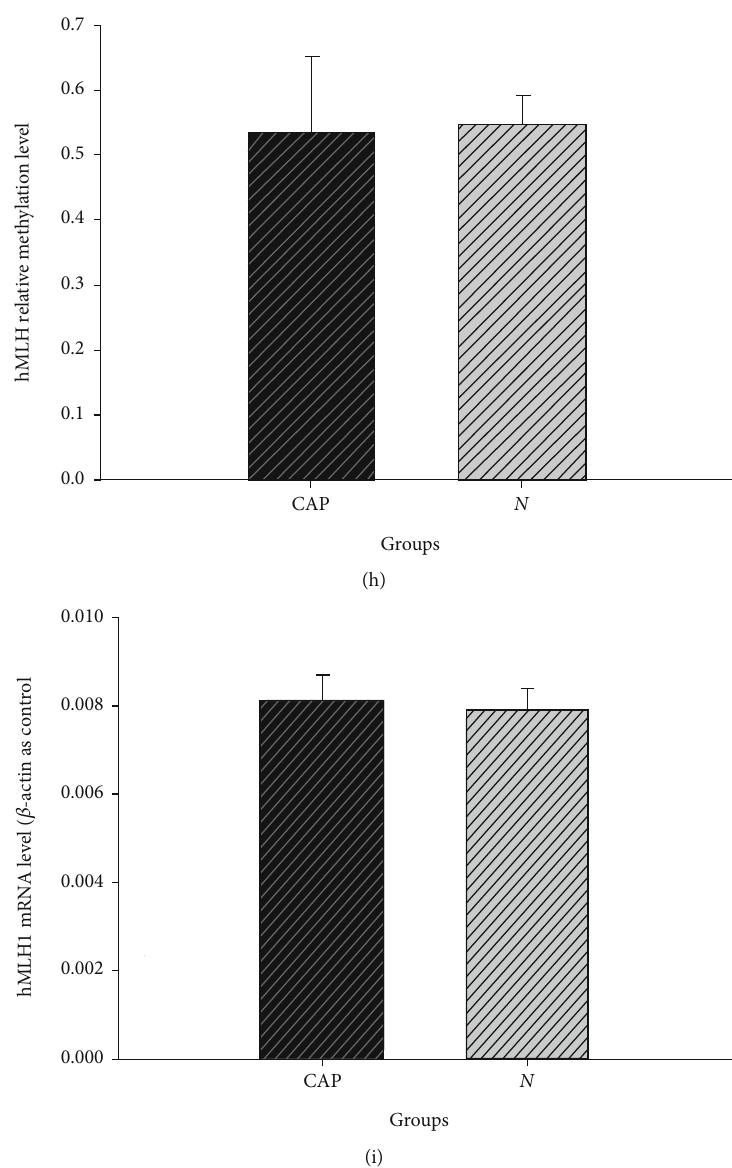
Figure 4: The methylation and expression of RASSF1A , p16 , and hMLH1 in CAP and NCM tissues. (a) MS-PCR analysis of methylation of RASSF1A . (b) Rate of DNA methylation in RASSF1A ( ∗ P < 0 : 05 ). (c) Real-time PCR analysis of the ration of RASSF1A mRNA to β -actin mRNA ( ∗ P < 0 : 05 ). (d) MS-PCR analysis of methylation of p16 . (e) Rate of DNA methylation in p16 . (f) Real-time PCR analysis of the ration of p16 mRNA to β -actin mRNA. (g) MS-PCR analysis of methylation of hMLH1 . (h) Rate of DNA methylation in hMLH1 . (i) Real-time PCR analysis of the ration of hMLH1 mRNA to β -actin